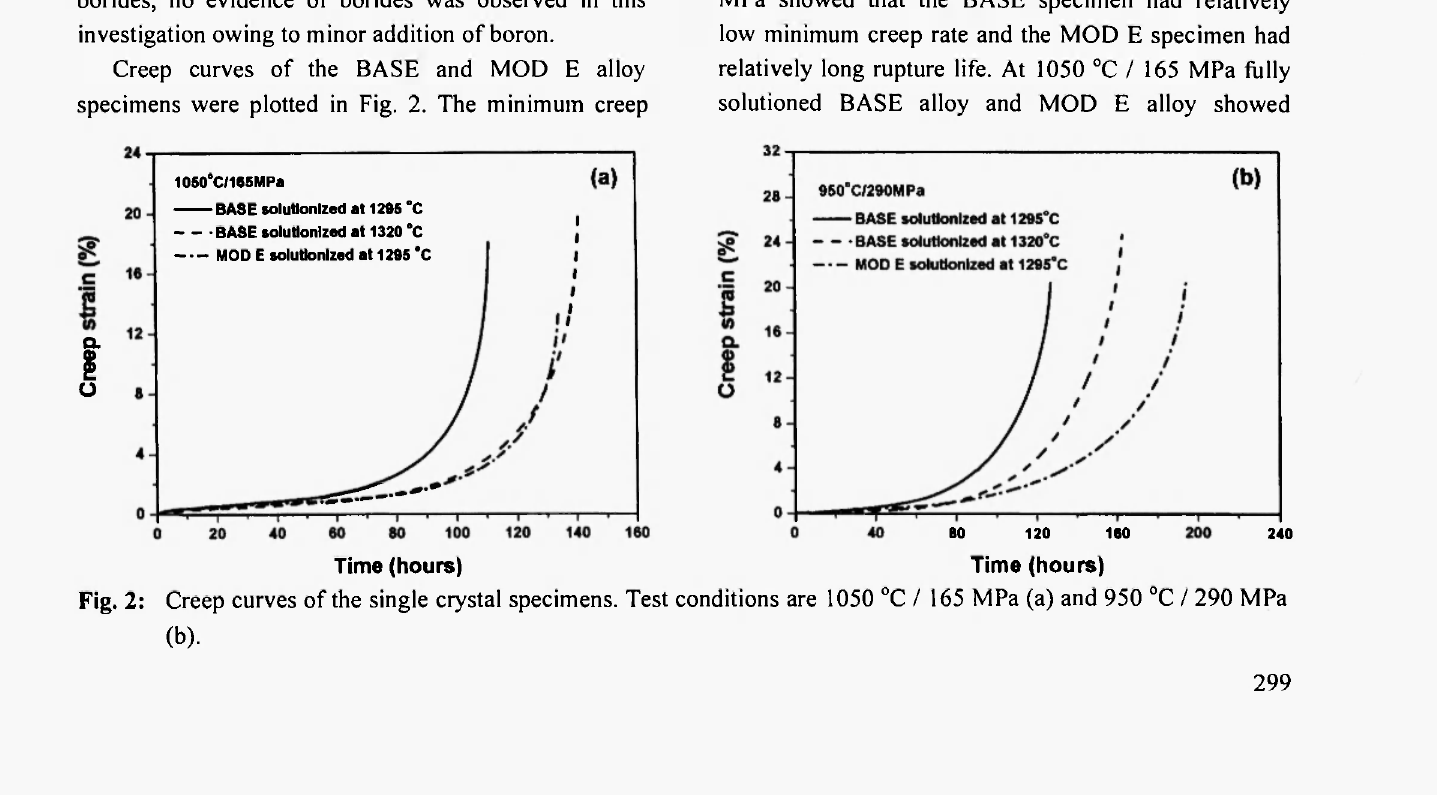
1050°C/16SMPa BASE solutlonlzed at 1295 °C BASE solutlonlzed at 1320